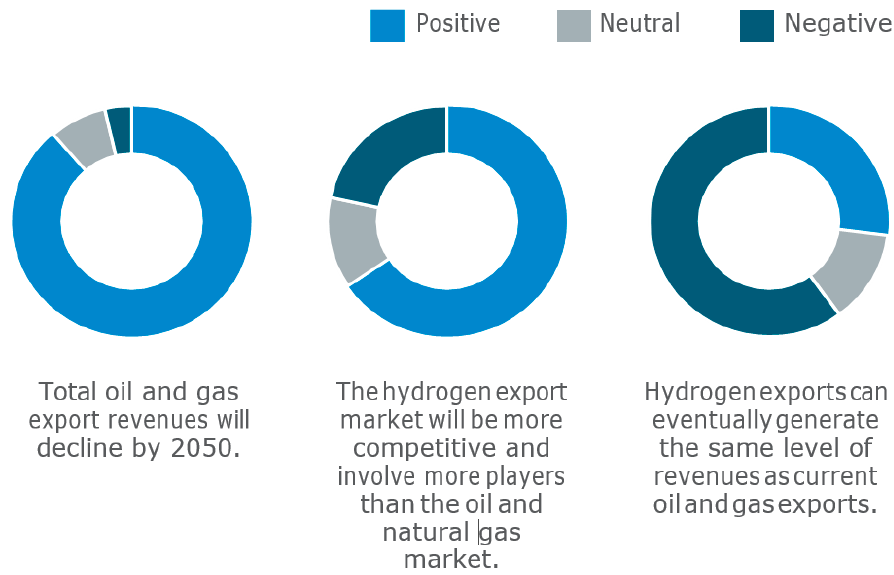
Figure 7. Expert opinions on the future profitability and market structure of hydrogen [13].